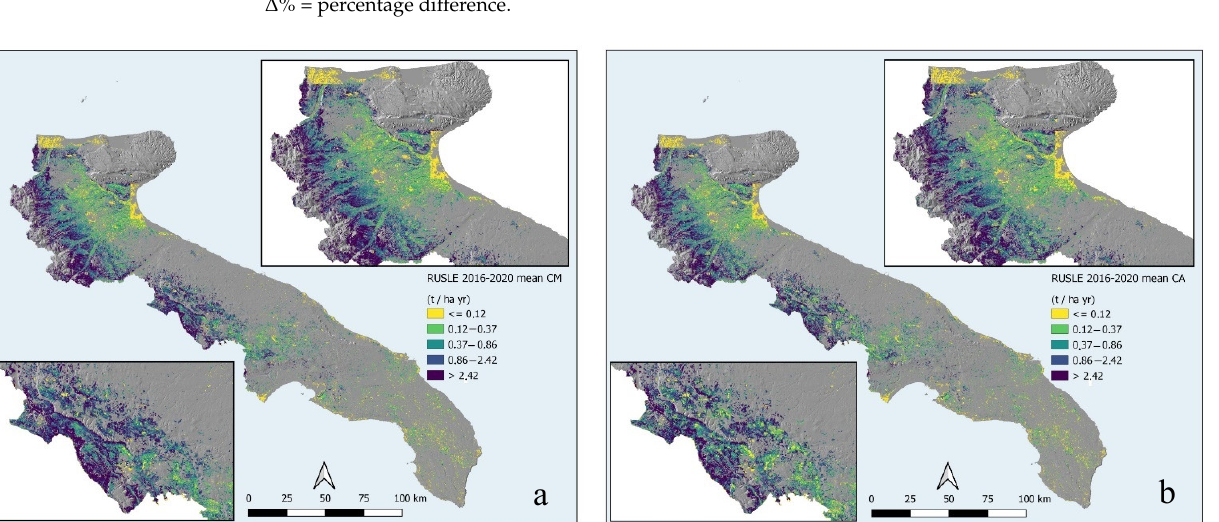
Table 2. RUSLE values for the 2016–2020 period in the Apulia region for each management system. RUSLE CM CA Agricultural Seasons 2016–2020 t ha − 1 t ha − 1 Δ % Mean 2.28 2.11 − 7.5